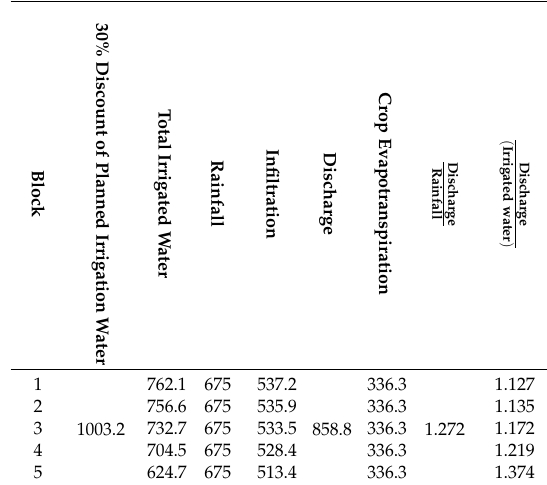
Table 5. Simulation result of 30% reduction of planned irrigation water depth (mm) during the first crop season. B l o c